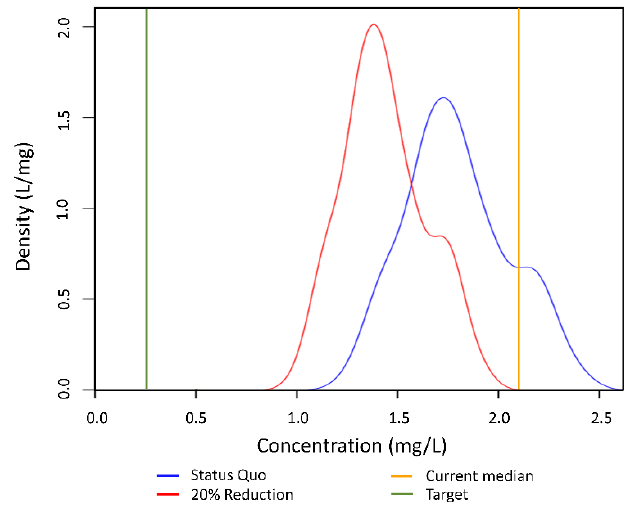
Figure 7. Example results for the probability density distribution of total nitrogen concentrations for a hypothetical load reduction scenario for Piako River at Paeroa-Tahuna Road Bridge.